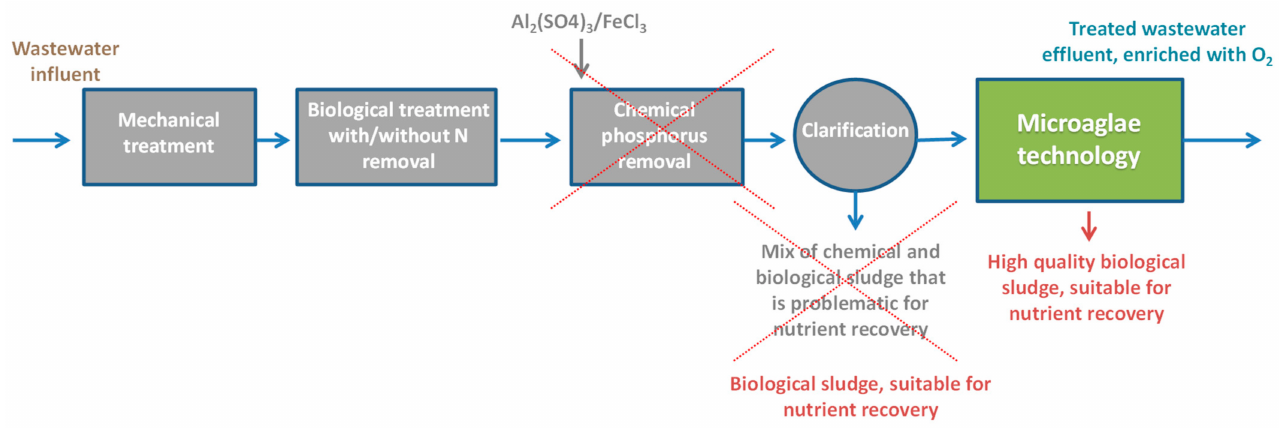
Figure 1. Algae-based wastewater as a tertiary treatment step for P and N removal. Scheme adapted from Valchev et al., 2021